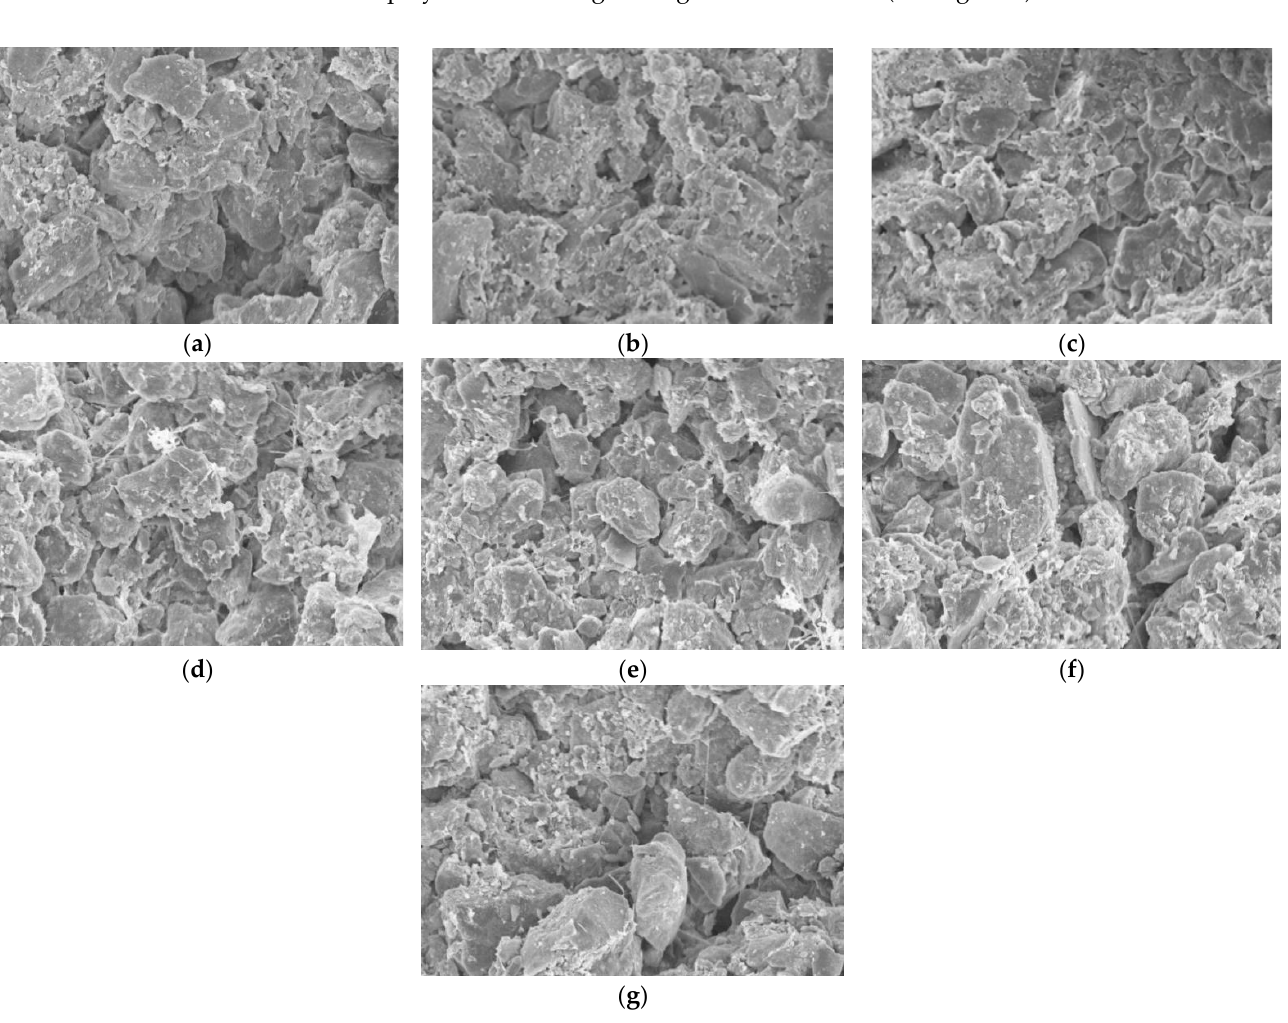
Figure 4. SEM images of lignosulfonate-modified loess with the stated percentages of lignosulfonate magnified at 500 times [46]. ( a ) 0%; ( b ) 0.5%; ( c ) 1%; ( d ) 1.5%; ( e ) 2%; ( f ) 3%; ( g ) 4%.